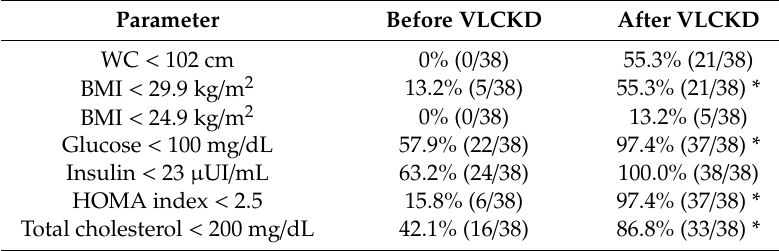
Table 3. Percentage of patients with biomarkers within the normal